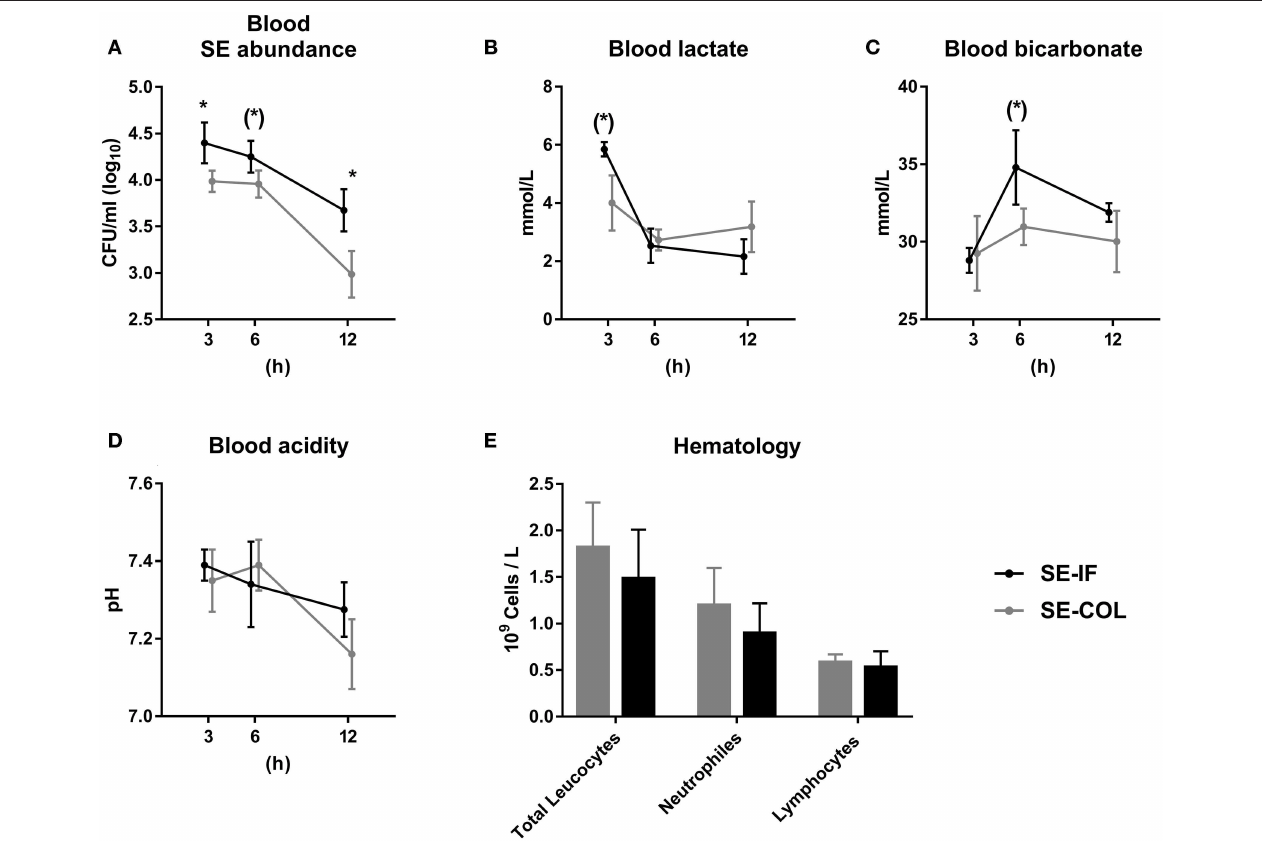
FIGURE 2 | Feeding of bovine colostrum improves clearance of Staphylococcus epidermidis in newborn preterm pigs. Results of Experiment 2 comparing preterm pigs infused with Staphylococcus epidermidis (SE) immediately after birth and fed either bovine colostrum or infant formula. (A) Abundance of SE in blood 3–12h post inoculation, shown as colony-forming units per milliliter of whole blood. (B) Blood lactate levels 3-12h post inoculation. (C) Blood bicarbonate levels 3–12h post inoculation. (D) Blood pH 3–12h post inoculation. (E) Total leucocyte, neutrophil and lymphocyte counts, taken 12h post inoculation. (A–E) Presented as means with corresponding standard errors. (*): Effect of diet ( p ≤ 0.1 ≥ 0.05), *Effect of diet ( p <